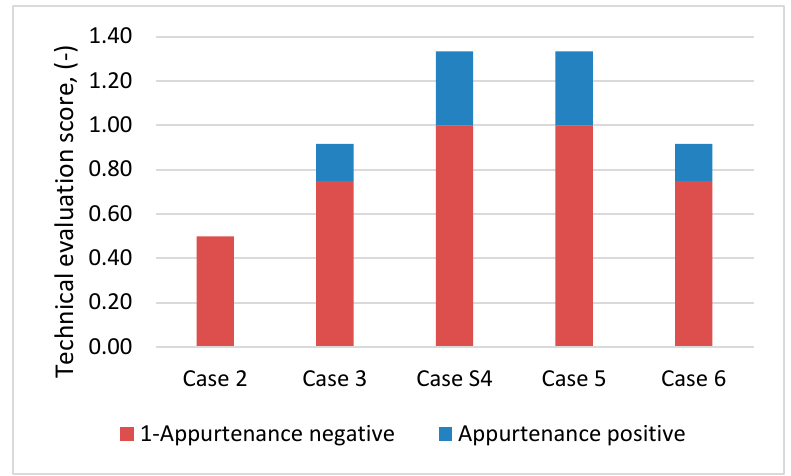
Figure 9. The overall evaluation of the cases studied according to the technical criteria.